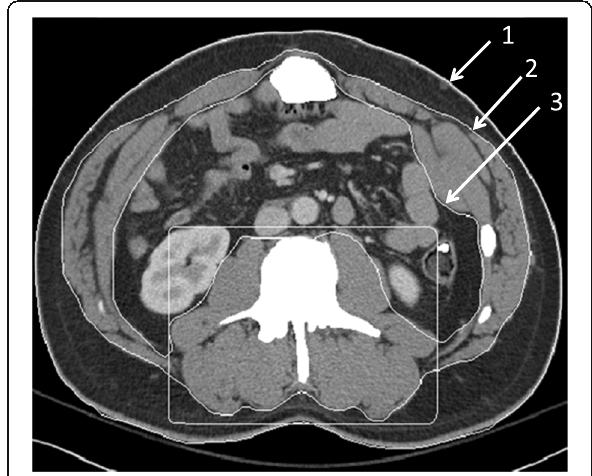
Fig. 1 Example of segmentation of a computed tomography image with boundary lines between external air and subcutaneous fat (1), between subcutaneous fat and abdominal wall/paraspinal muscles (2), and between abdominal wall/paraspinal muscles and visceral fat (3). The box around the paraspinal muscles allows the algorithm to separately calculate the paraspinal muscle area (if this information is